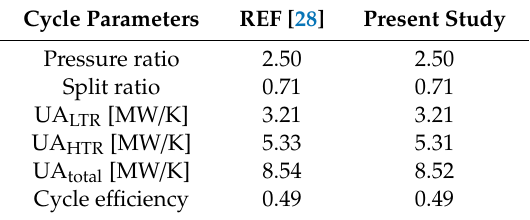
Table 4. Comparison results between the present study and reference